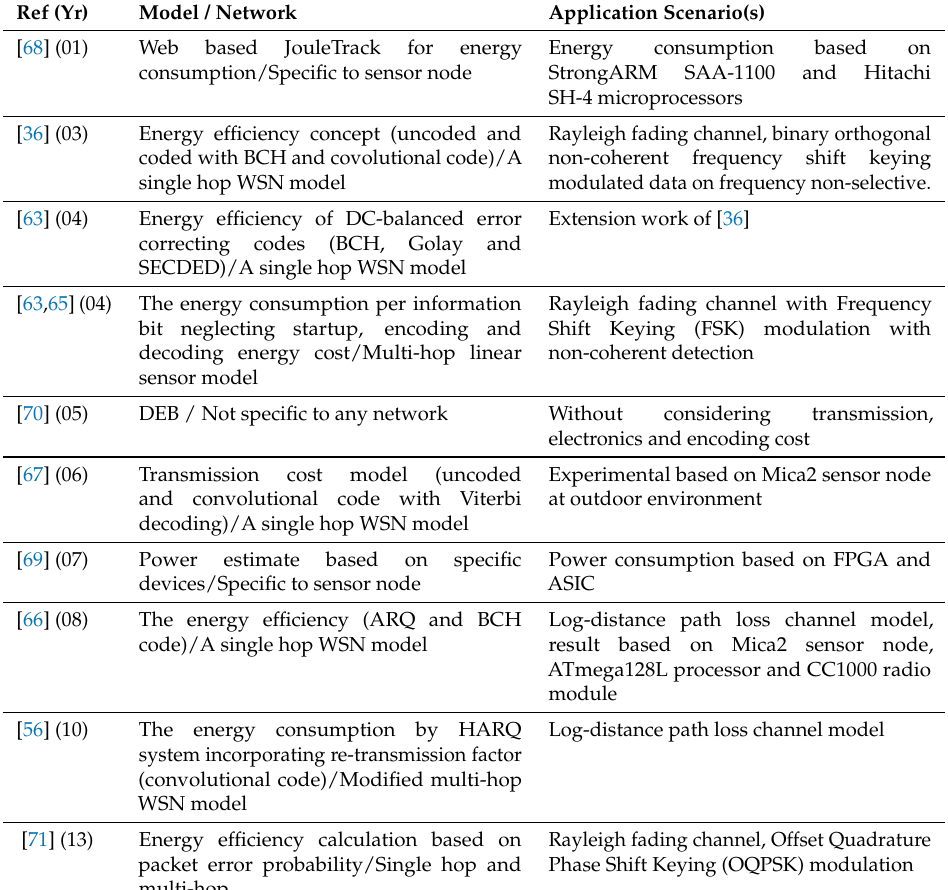
Table 1. A summary of energy consumption and efficiency